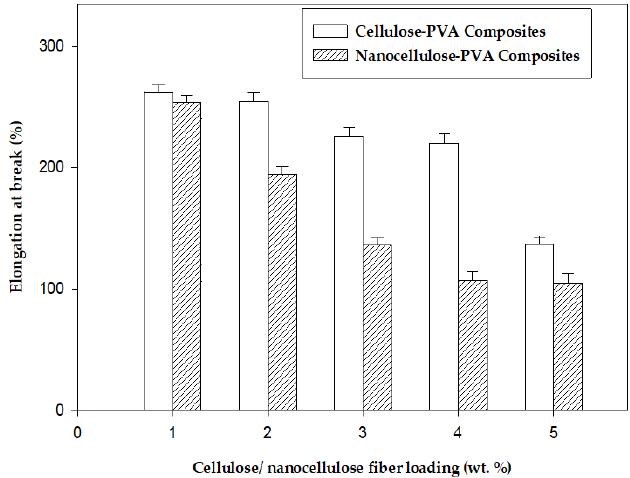
Figure 6. Elongation at break (%) vs. cellulose / nanocellulose fiber loading (wt.%) of cellulose / nanocellulose reinforced PVA composites.